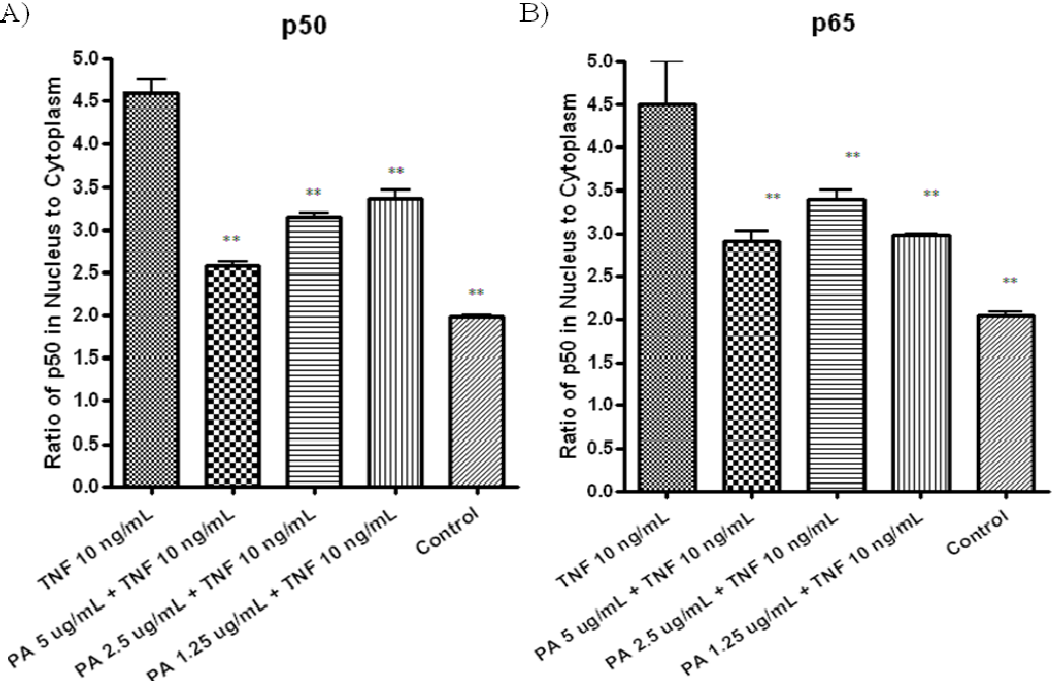
Figure 4. A549 cells were treated with various concentrations of PA for 30 min, followed by treatment with 10 ng/mL TNF- α for another 30 min. Nuclear and cytoplasmic fractions of the A549 treated cells were extracted, the concentration of the active form of ( A ) NF- κ B/p50; and ( B ) NF- κ B/p65 in both fractions were measured with ELISA kits. Differences of NF- κ B/p50, NF- κ B/p65 in the nuclear and cytoplasmic fractions are